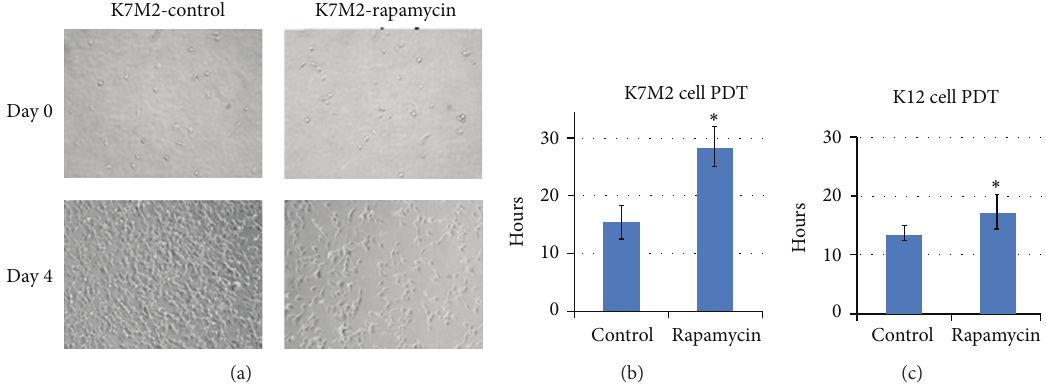
Figure 3: Rapamycin treatment reduces K7M2 cell proliferation. (a) K7M2 cells were cultured with media containing 10 𝜇 M rapamycin or DMSO only (control) for four days. Representative images of cell density at the beginning and end of treatment are shown. (b) A quantitative analysis of (a) to determine the population doubling time (PDT) of K7M2 cells in rapamycin-treated and control groups (DMSO only). (c) A quantitative analysis determining the population doubling time (PDT) of K12 cells in rapamycin-treated and control groups (DMSO only). Asterisks ( ∗ ) indicate statistically significant differences ( 𝑃 < 0.05 ).